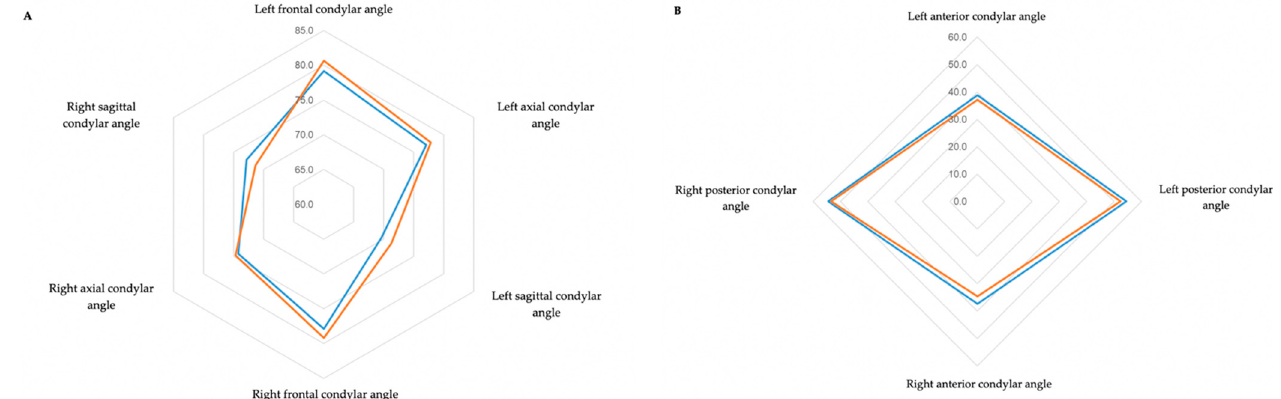
Figure 2. ( A ) Radar chart of condylar angles in the three planes of space. ( B ) Radar chart of condylar Figure 2. ( a ) Radar chart of condylar angles in the three planes of space. ( b ) Radar chart of condylar angles in the sagittal plane to assess condylar position. angles in the sagittal plane to assess condylar position.